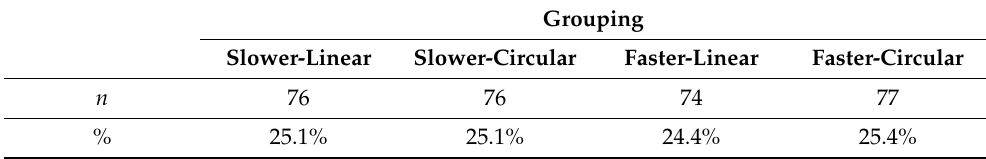
Table 1. Participant’s grouping information ( n = 303).